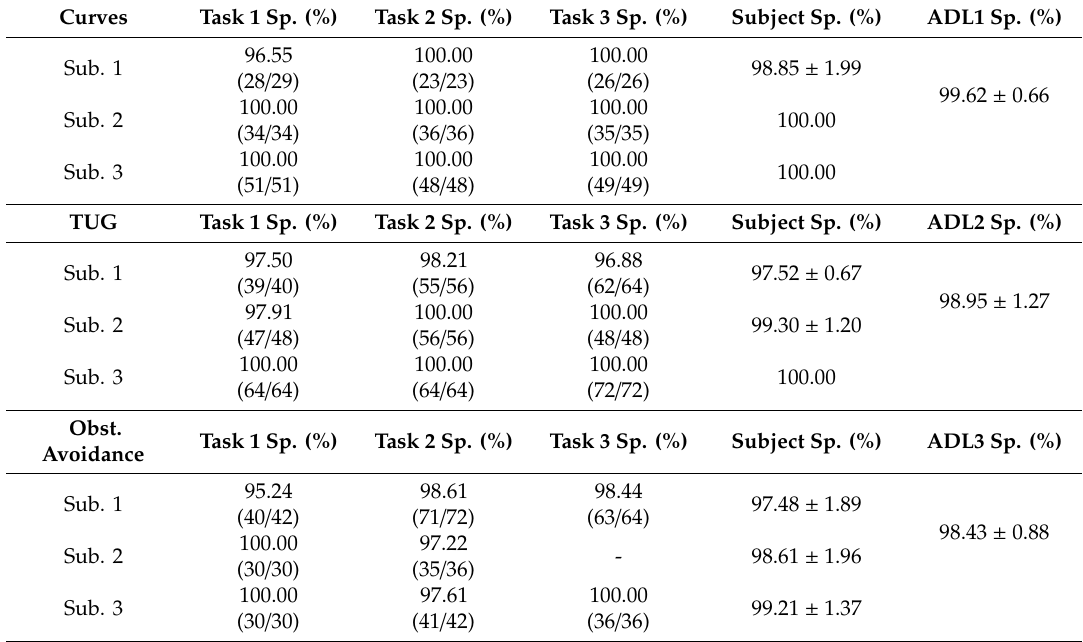
Table 3. ADL-related specificity